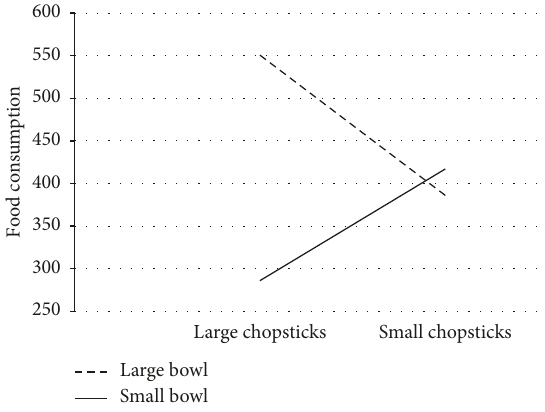
Figure 2: Influences of bowl and chopstick size on food con- sumption under the bright condition.